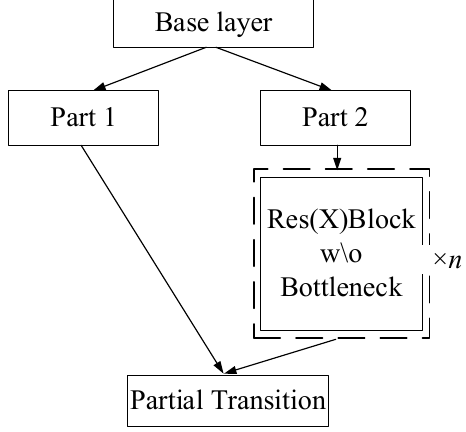
Figure 5. CSPNet network structure.